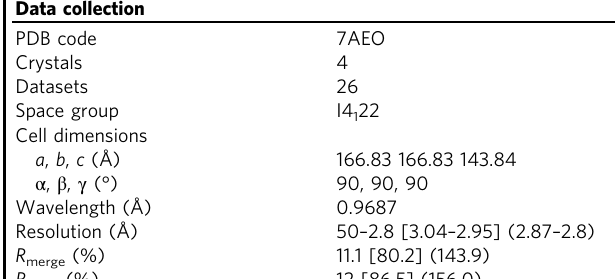
Table 1 Data collection and structure re fi nement statistics for the PARP2 WGRCAT + 5 ′ P-dsDNA complex